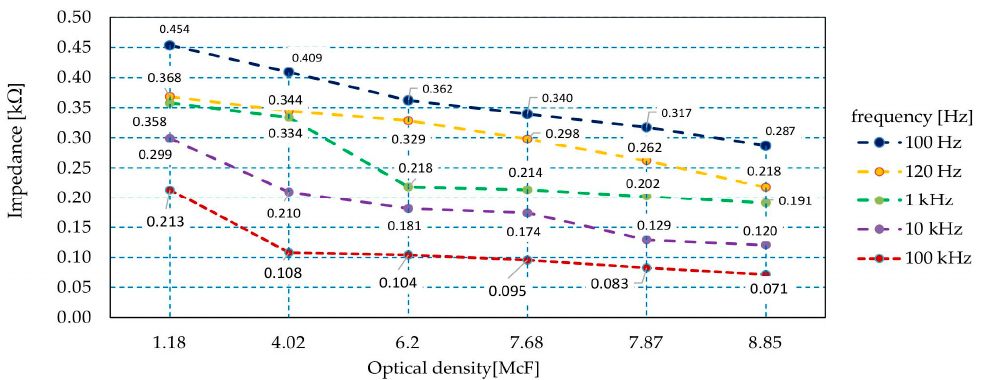
Figure 11. The dependence of impedance of the sensor with regard to the number of bacteria in the suspension.